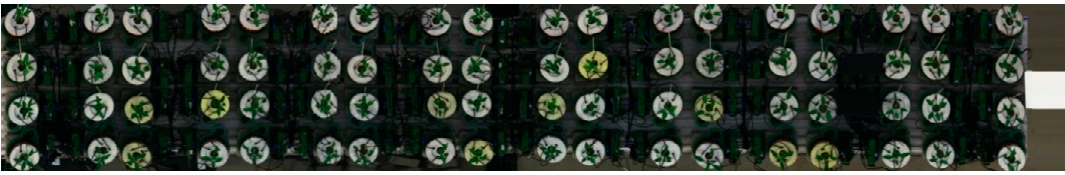
Figure 2. A view of the imaging platform as it moved above the plants. The platform was constructed from lightweight materials and deployed within just a few hours.